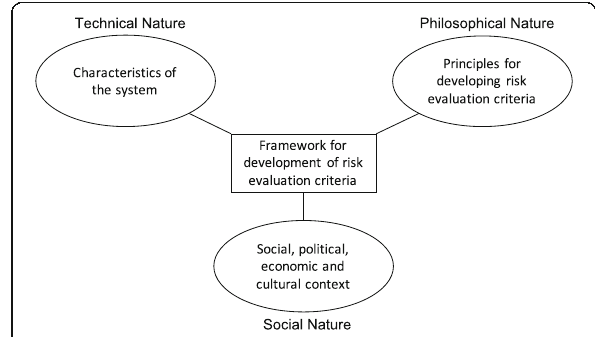
Fig. 1 Aspects (ellipses) to be considered within a framework for developing proposed risk to life evaluation